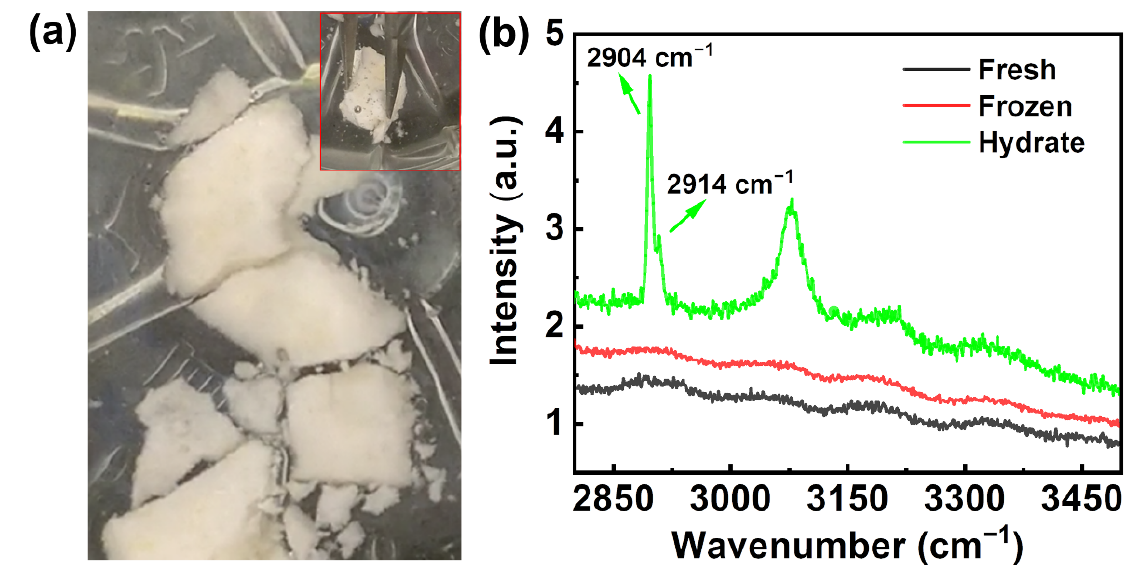
Figure 4. ( a ) Photographs of corncob pith after synthesis of methane hydrate within it (the illustration shows the release of methane gas when the hydrate in the corncob decomposes). ( b ) Raman spectrum of the methane gas stored in the corncob pith in the form of methane hydrate. Fresh: fresh corncob pith. Frozen: corncob pith frozen in liquid nitrogen. Hydrate: corncob pith with methane hydrate formed within it.